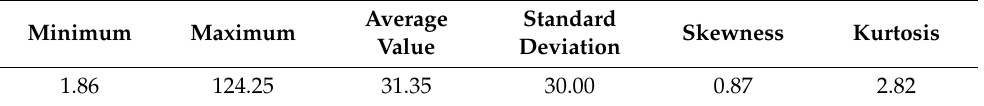
Table 1. Descriptive statistics of Chl-a concentration (mg/m 3